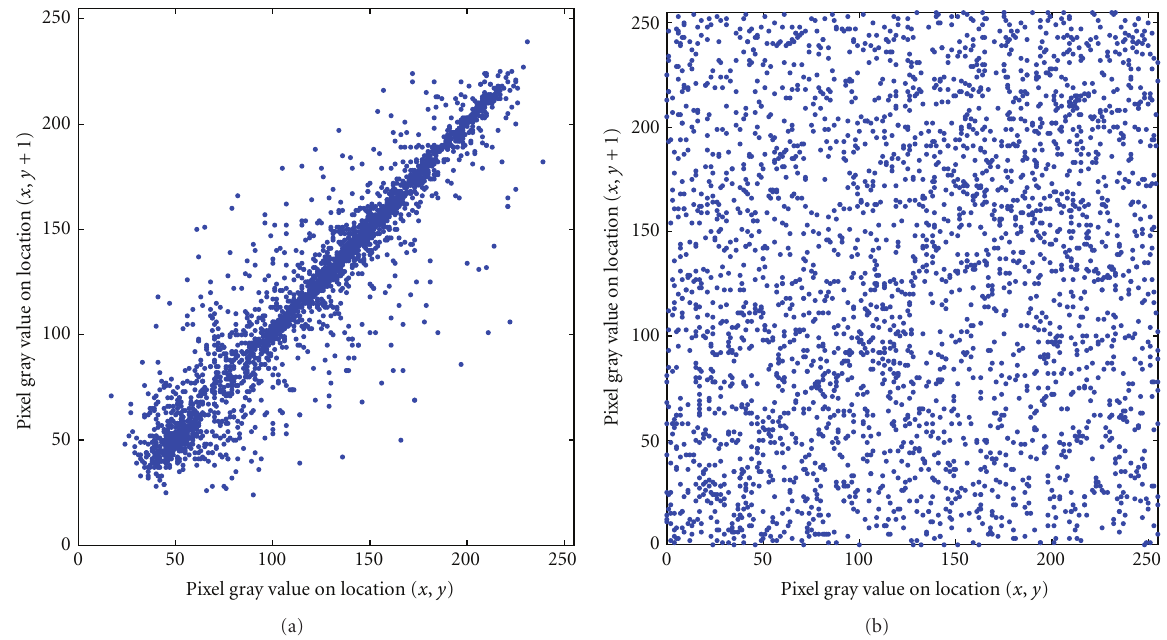
Figure 6: Correlation of two horizontally adjacent pixels in the original image and in the encrypted image.